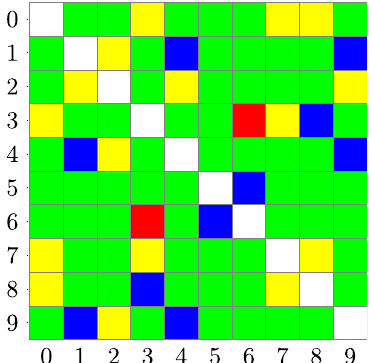
Fig. 8 Color map of p values assessing whether two clusters are in signi fi cant agreement in terms of free-energy predictions. Green cells indicate that p value is lower than the threshold (0.01) as expected, blue indicates that p value was greater than the threshold as expected, yellow indicates that p value was unexpectedly lower than the threshold, and red indicates that p value was unexpectedly higher than the threshold. The exact values could be seen in Supplementary Note